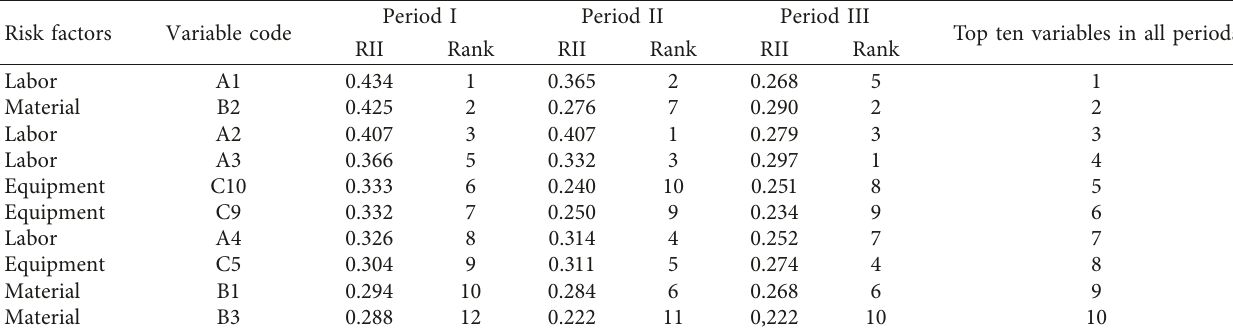
Table 15: Ten potential rankings in all three